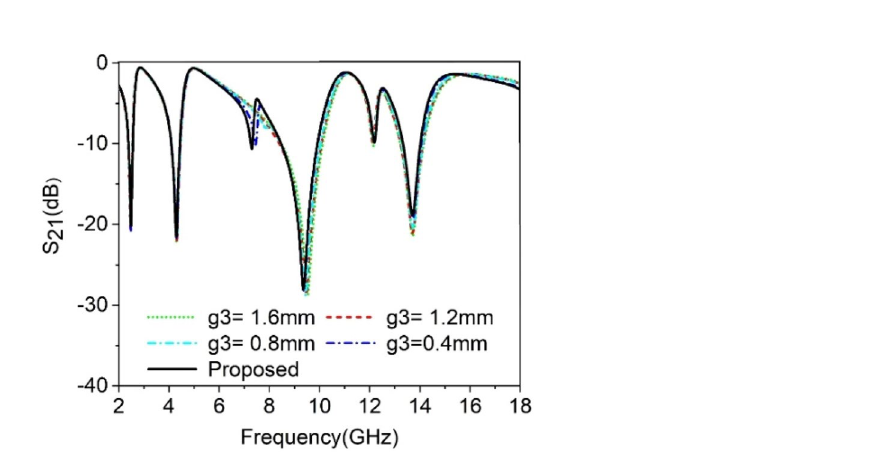
Figure 8. The transmission coefficient of the proposed unit cell for split gap variation,